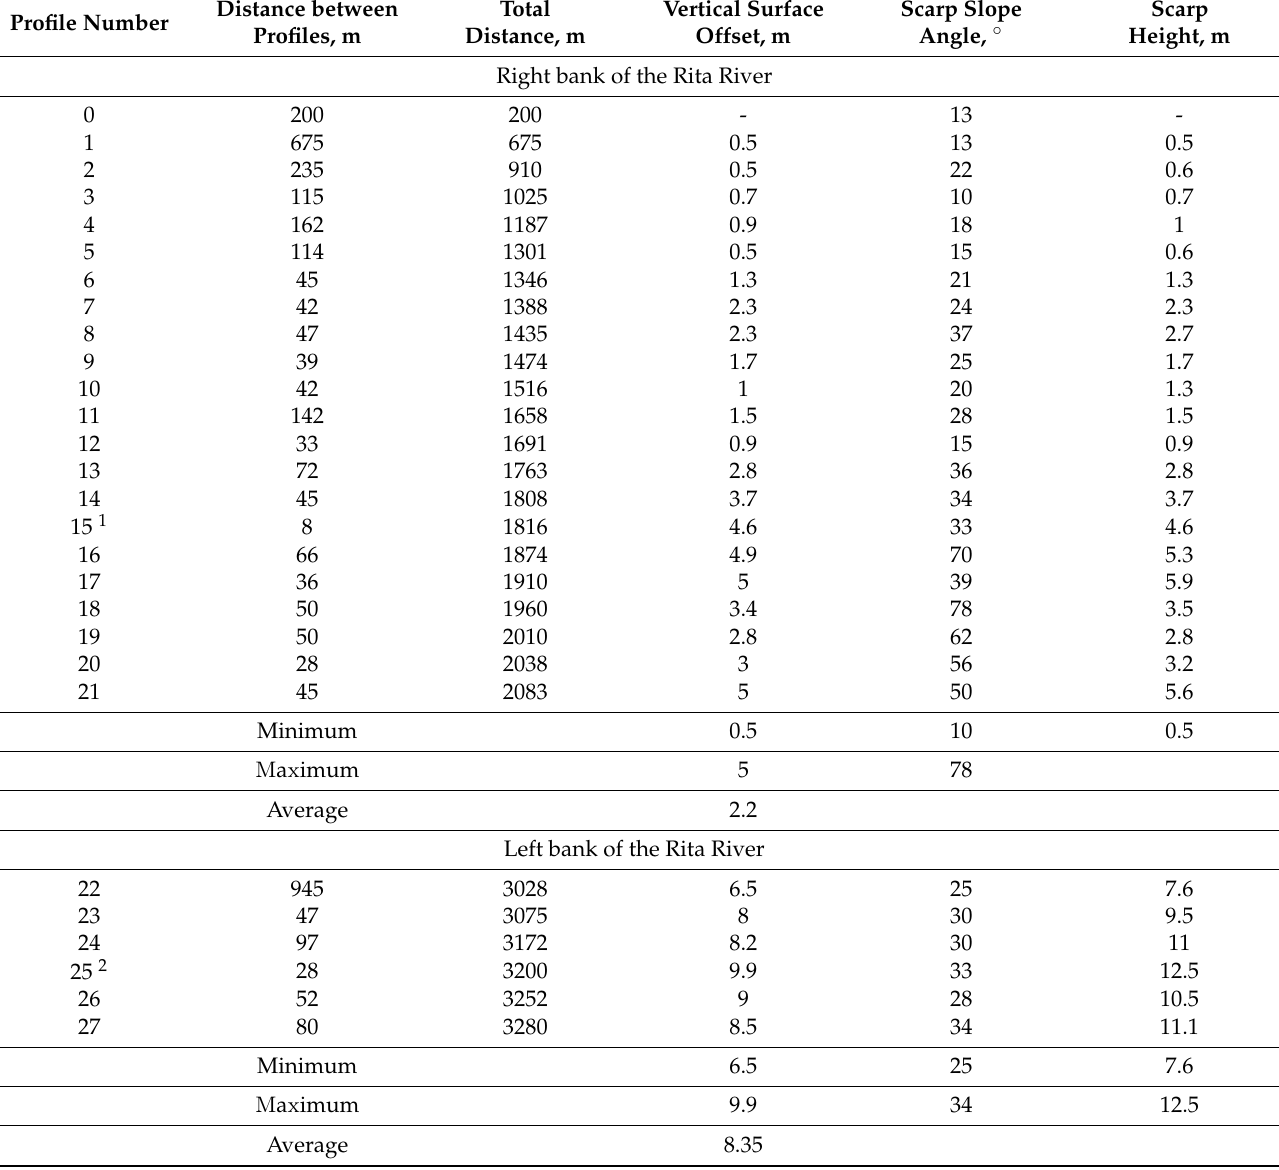
Table 1. Parameters of paleoseismic scarps in the distal part of the Rita River